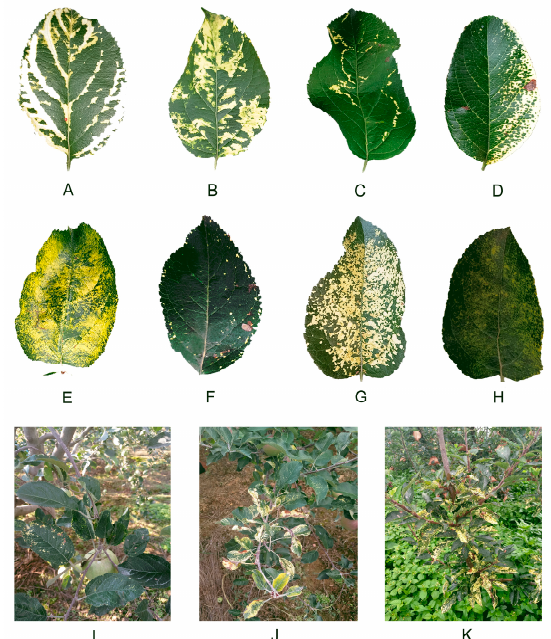
Figure 6. Symptoms of apple mosaic disease. ( A – H ) Mosaic leaves. ( A ) striated type, ( B ) plaque-like type, ( C ) annular type, ( D ) secund type, ( E ) painted type, ( F ) limbic type, ( G ) leopard-print type, and ( H ) mottled type. ( I , J , K ) Apple trees with mosaic disease.